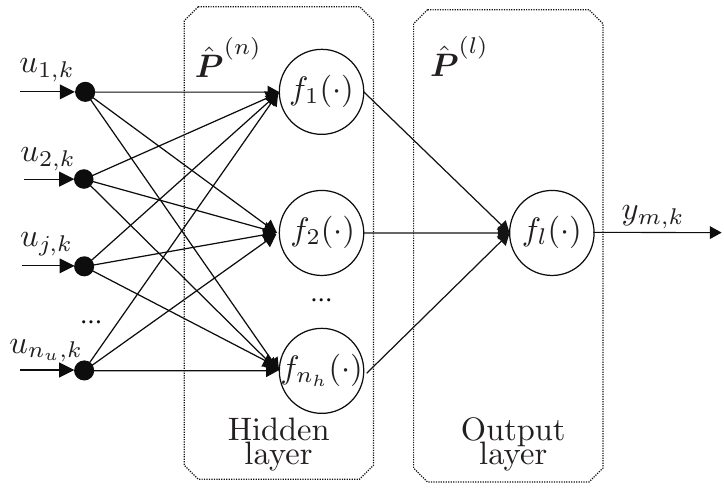
Figure 1. The architecture of the Multi-Layer Perceptron (MLP) used for the system